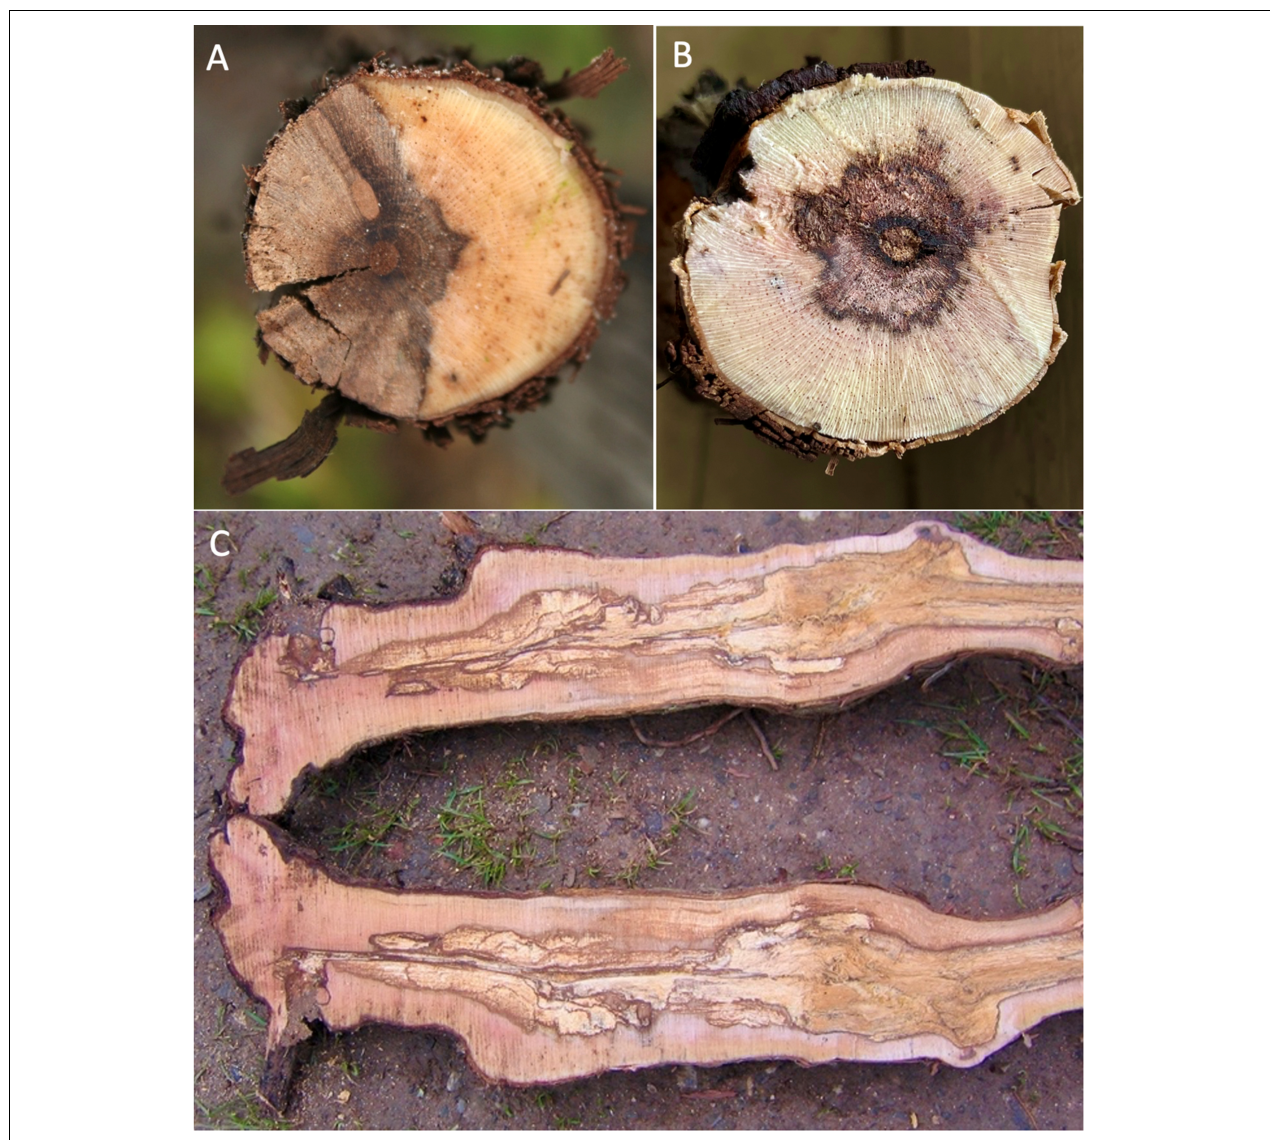
FIGURE 1 | (A) Cross-section of grapevine trunk with necrosis and wood degradation typical of Eutypa dieback. (B,C) Cross-section and longitudinal sections, respectively, of grapevine trunk with necrosis and wood degradation typical of Esca